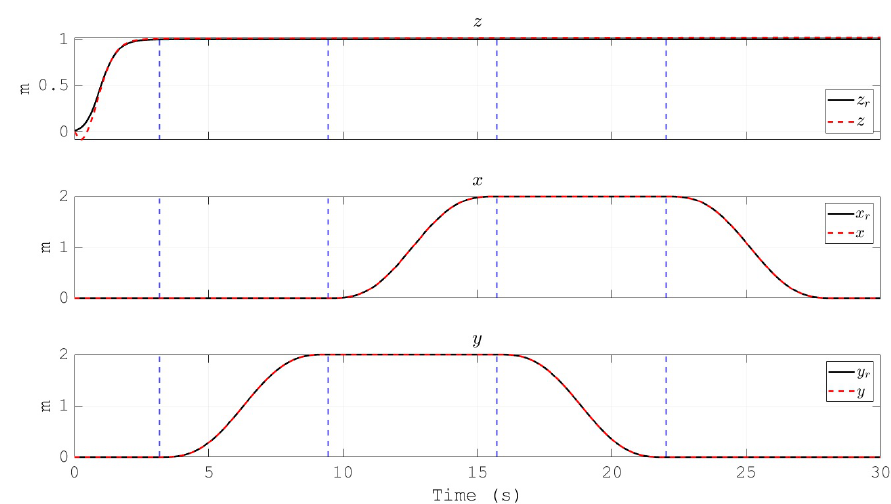
Figure 12. Cartesian coordinates of the position of the multirotor. Only the altitude z is tracking its reference z r .